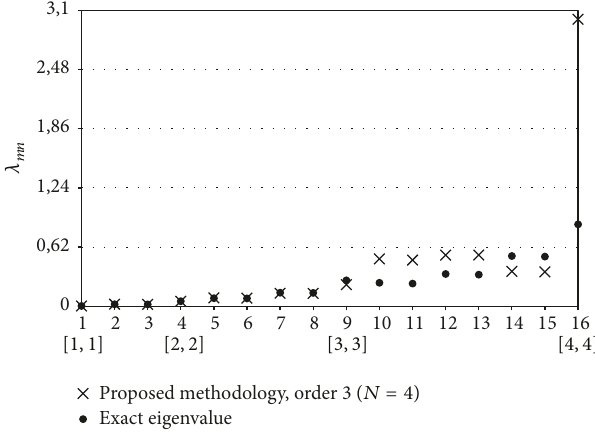
Figure 25: Hinged rectangular plate: gence).